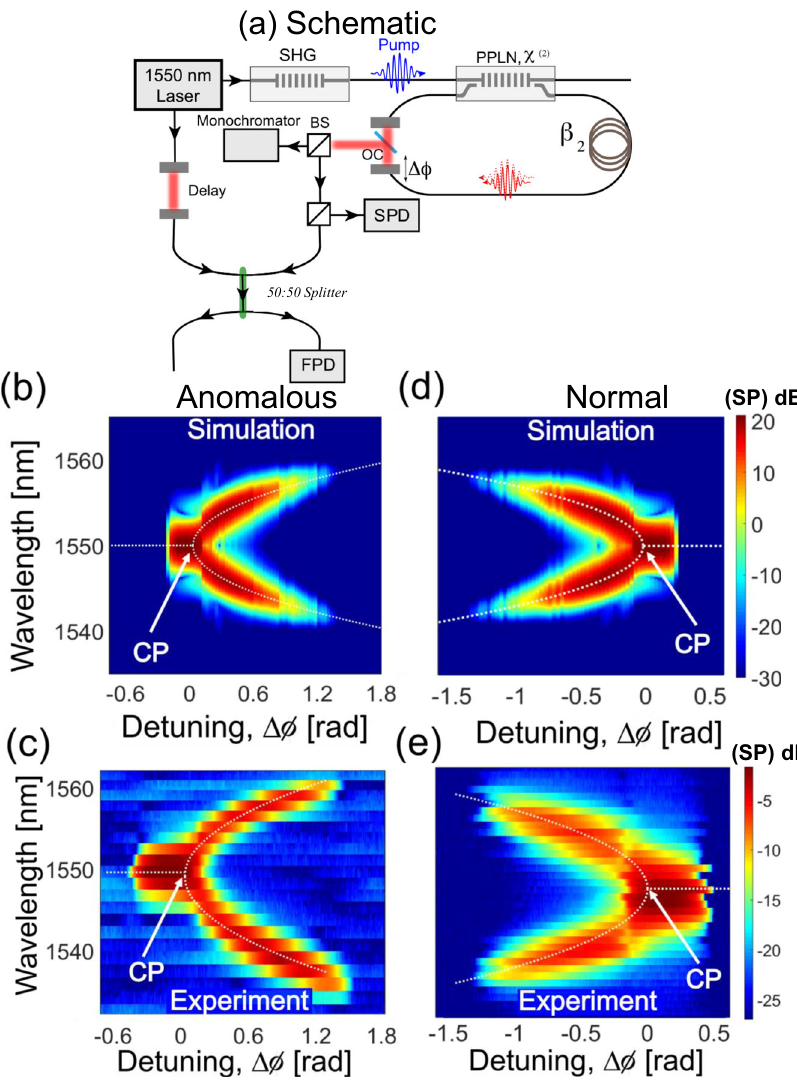
Fig. 2 Second-order spectral phase transition in an OPO. a Schematic of the experimental setup, which implements the spectral phase transition in a guided-wave OPO based on PPLN. BS beam splitter, OC output coupler, SPD slow photo-detector, FPD fast photo-detector, SHG second harmonic generation. Spectrum (SP) as a function of detuning obtained through numerical simulation b in anomalous dispersion regime (dotted line represents the theoretically expected spectral splitting, which in the non-degenerate regime is given by: δω ¼ results capturing the second-order critical point c in anomalous dispersion regime, e in normal dispersion regime. It closely follows the square-root behavior (dotted line) in the non-degenerate regime. Color bar represents power spectral density in